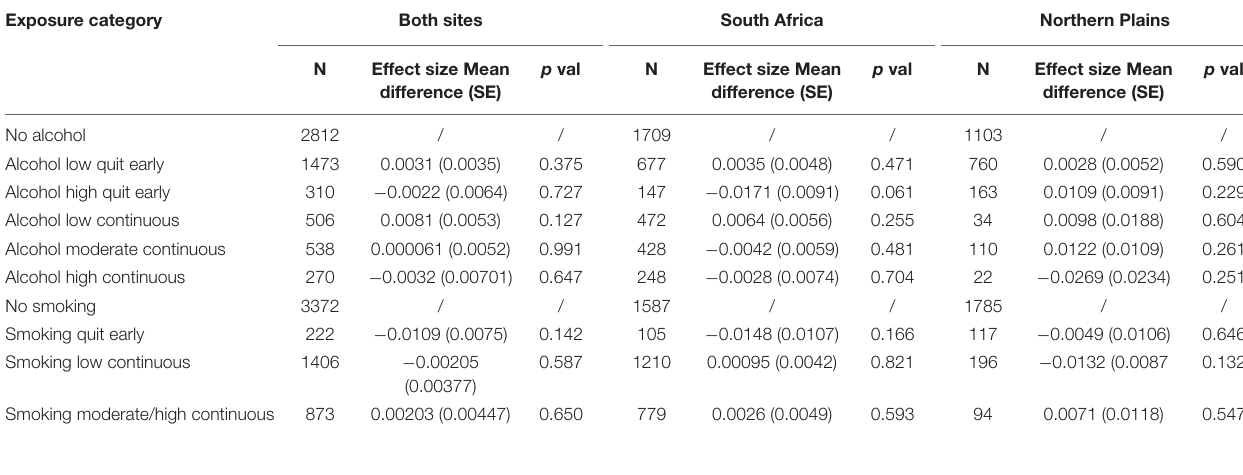
TABLE 12 | Linear regression results from alcohol and smoking exposure predicting HR/fetal movement